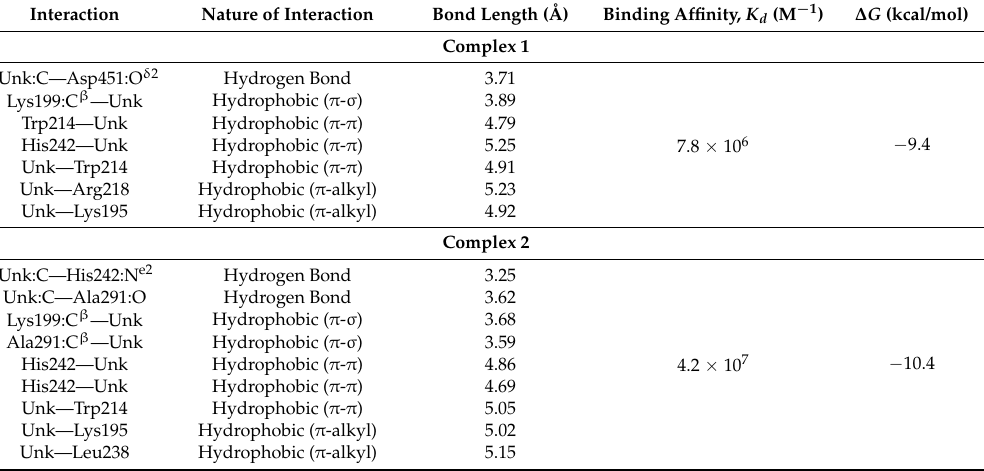
Table 2. List of residues of HSA interaction with different